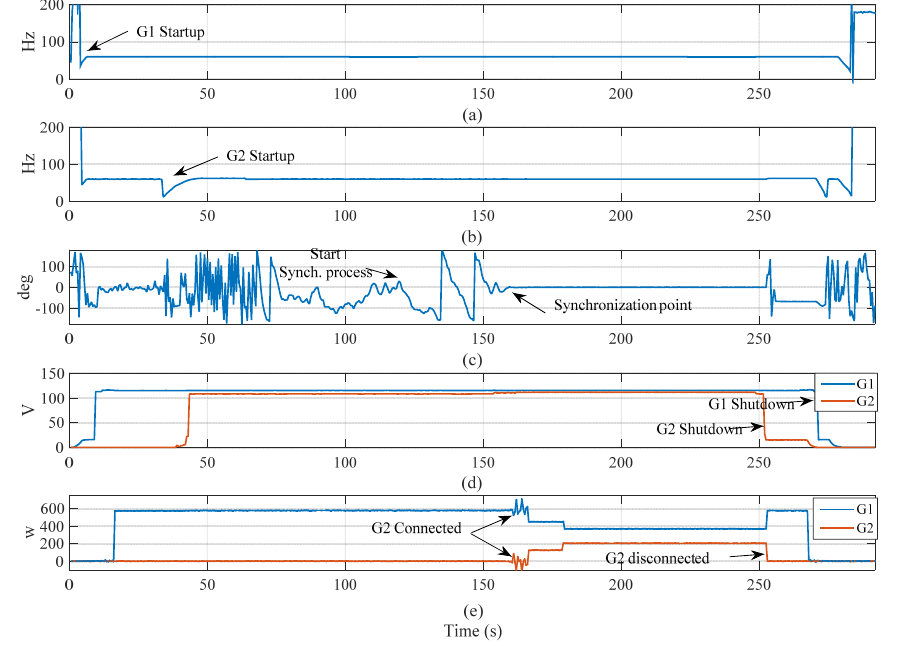
Figure 16. Experimental results, voltage, frequency and synchronization switch status ( a ) generator 1; ( b ) generator 2; ( c ) generator 3; and ( d ) generator 4; and ( e ) Generators power.